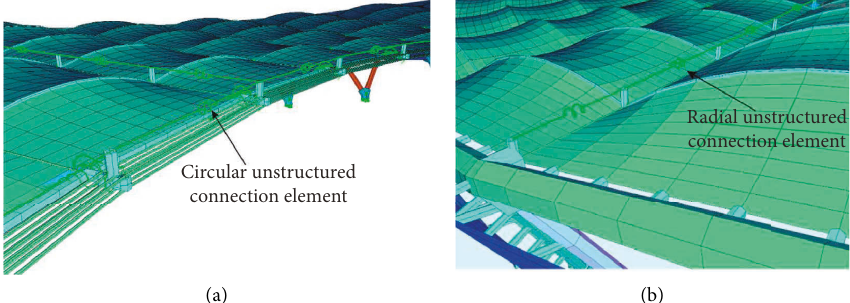
Figure 11: Calculation model of the accessory structure. (a) Circular catwalk. (b) Radial